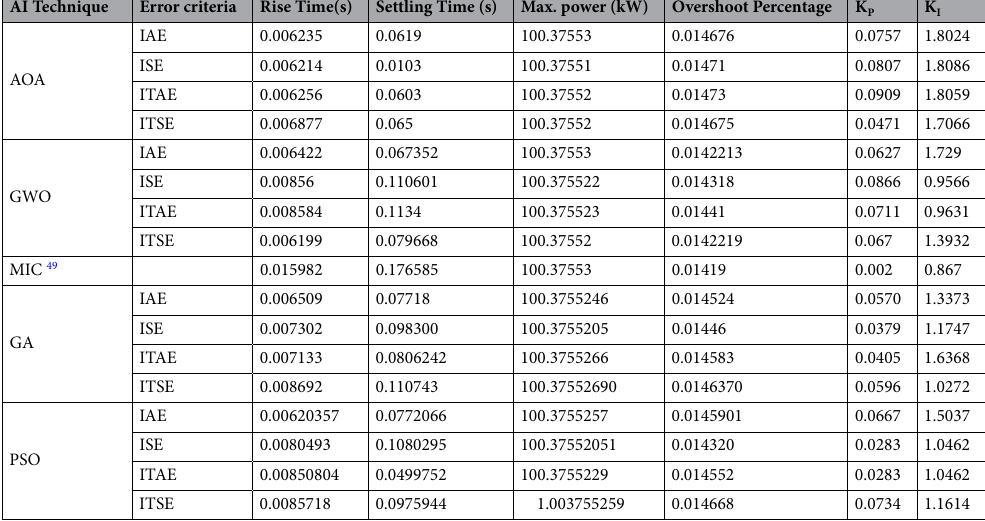
Table 4. Optimal gains of AOA, GWO, MIC, GA, and